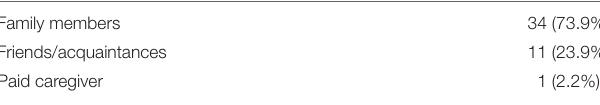
TABLE 1 | Relationship of the companion to the patient. Family members 34